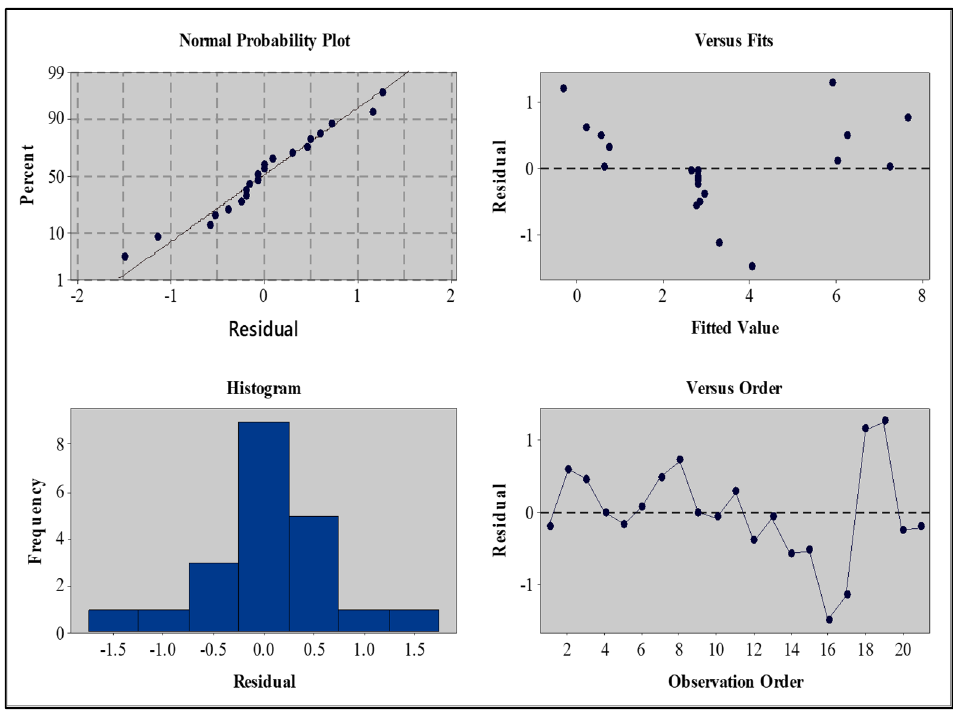
Figure 4. Residual plot for compressive strength of B-FCB.